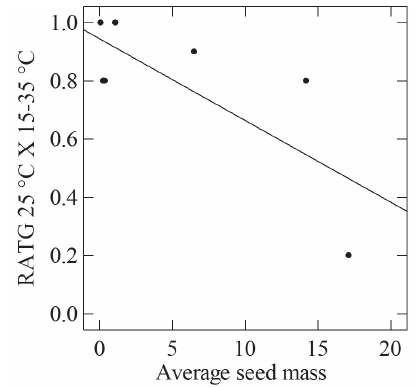
Figure 2 - Relationship between average seed fresh mass and Relative Alternating Temperature Germination (RATG) of seven pioneer tree species from the Central Amazon. RATG: percentage of germination under constant temperature (25 °C) divided by the sum of germination percentages at constant temperature (25°C) and alternating temperatures (12-12 h;15-35